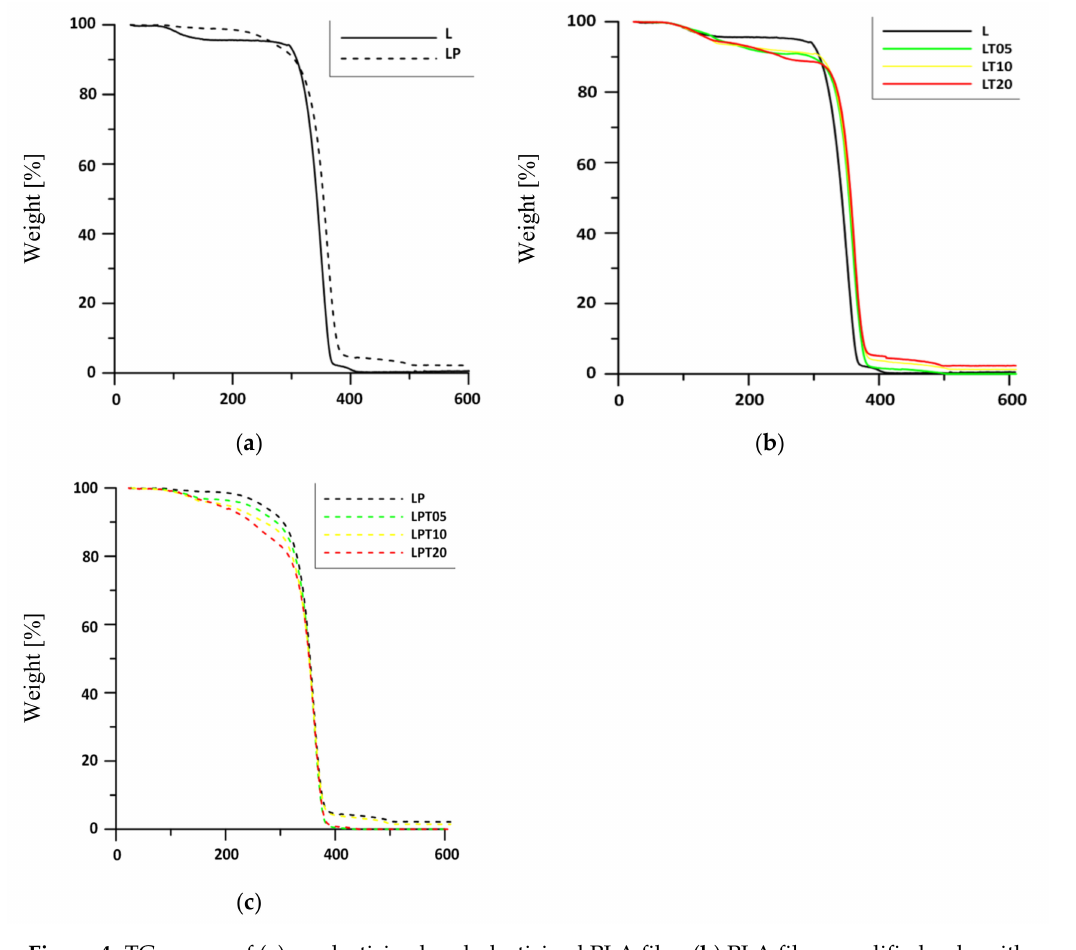
Figure 4. TG curves of ( a ) unplasticized and plasticized PLA film, ( b ) PLA films modified only with TTO and ( c ) PLA based materials with PEG and TTO